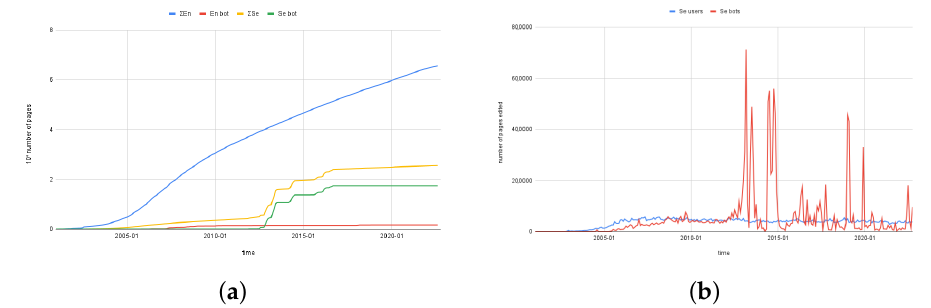
Figure 8. ( a ) Evolution over time of the total number of articles present in the English (En) and Swedish (Se) Wikipedias and the corresponding bot-created items. ( b ) Number of articles edited, excluding redirect pages, by users and by bots in the Swedish Wikipedia. We can see how the discontinuity in the trend for both counts is due to bot activity. Data collected from